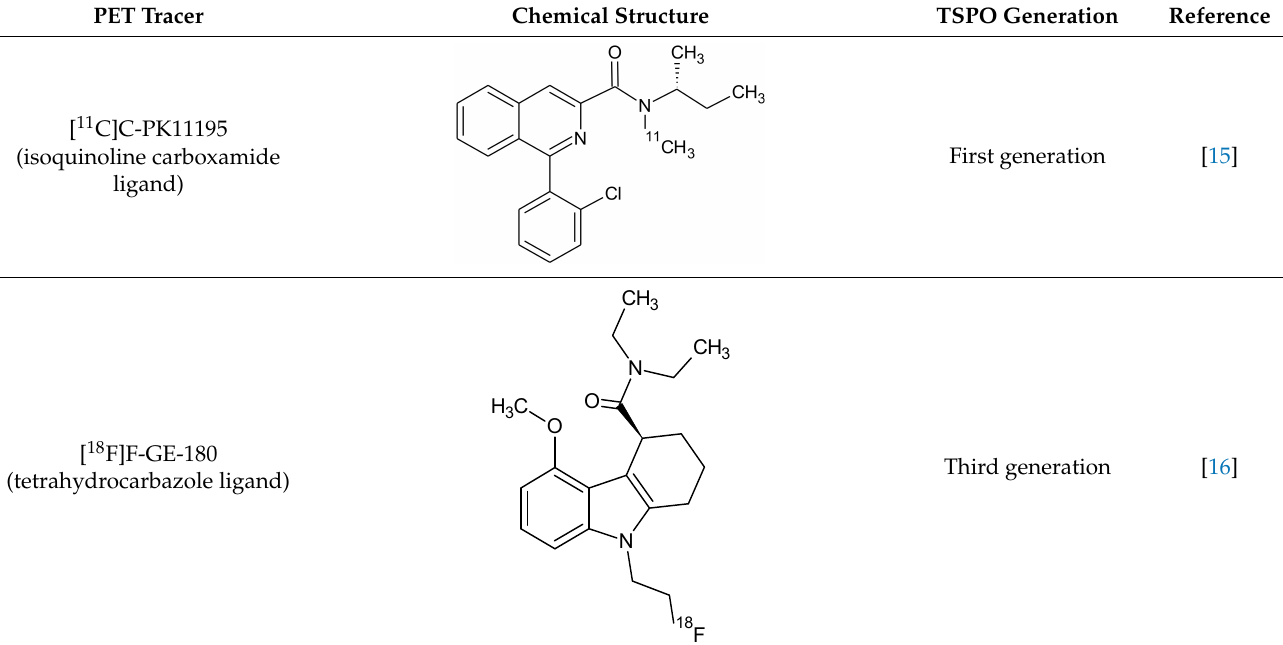
Table 1. Summary of TSPO PET tracers most commonly described in literature. PET